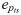
Simulation results for the proposed algorithm.(a), (b) and (c): Plots of the genotype error (eZ), proportion error (eW) and error of success probability (epts) versus different sample sizes for subclones C ∈ {3, 4, 5}. (d), (e) and (f): Posterior distributions of C, for C = 3, 4, and 5.